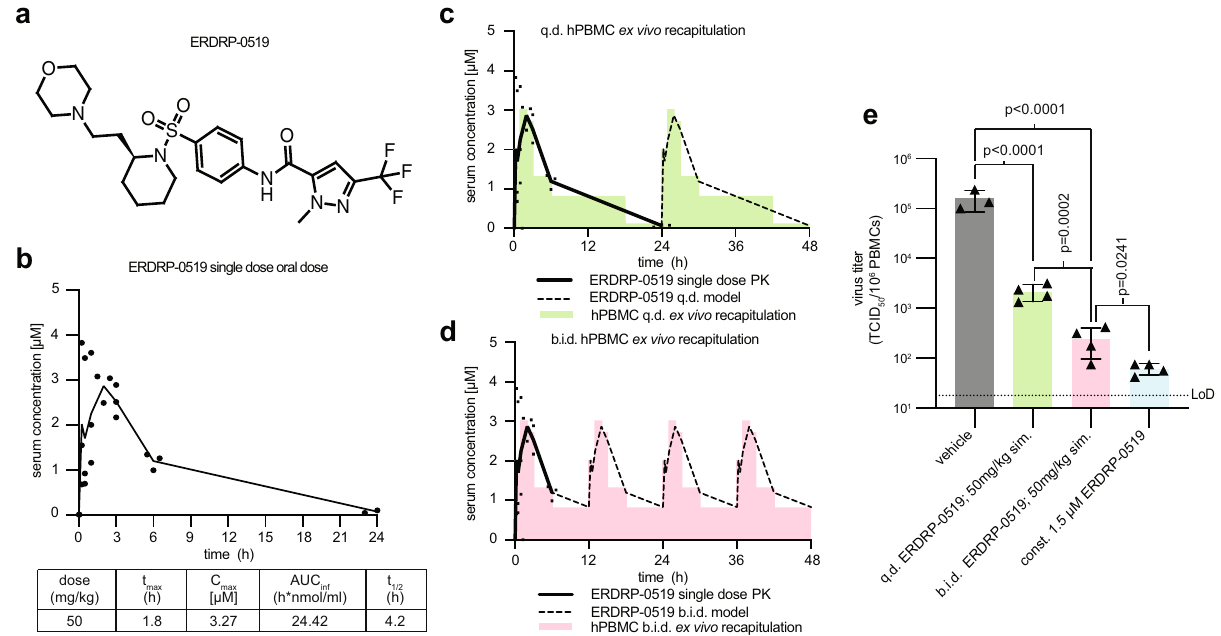
Fig. 1 Single-dose oral pharmacokinetic study of ERDRP-0519 in squirrel monkeys. a , b ERDRP-0519 ( a ) was administered intragastrically at 50 mg/kg bodyweight in a poly(ethylene glycol)-200 formulation at a concentration of 10 mg/ml. ERDRP-0519 serum concentrations from blood samples were measured by liquid chromatography with tandem mass spectrometry (LC/MS/MS) ( b ); mean plasma concentrations are shown ( n = 3). Pharmacokinetic parameters were calculated using the WinNonlin PK software package. C max maximum calculated concentration, AUC inf area under the curve extrapolated to in fi nity, t 1/2 terminal elimination half-life. c , d PK-informed ex vivo assessment of anti-MeV ef fi cacy in human peripheral mononuclear cells (hPBMCs) recapitulating once ( quaque die ; q.d. ) or twice ( bis in die ; b.i.d ) daily ERDRP-0519 dosing. Solid lines show the experimentally measured single-dose PK pro fi le of the compound in squirrel monkeys; dashed lines represent the projected PK pro fi les, assuming no drug build-up after multi-dose administration; green and magenta blocks illustrate the experimentally applied concentrations in the 48-h ex vivo recapitulation of physiologically-achievable drug levels. e Progeny MeV titers observed in the ex vivo recapitulations shown in c , d . Statistical analysis through one-way ANOVA with Tukey ’ s multiple comparison post-hoc test. Symbols show individual biological repeats and bars illustrate the mean. N = 3 (vehicle) or n = 4 (all other groups), exact p values are stated, and error bars represent standard deviations; LoD limit of